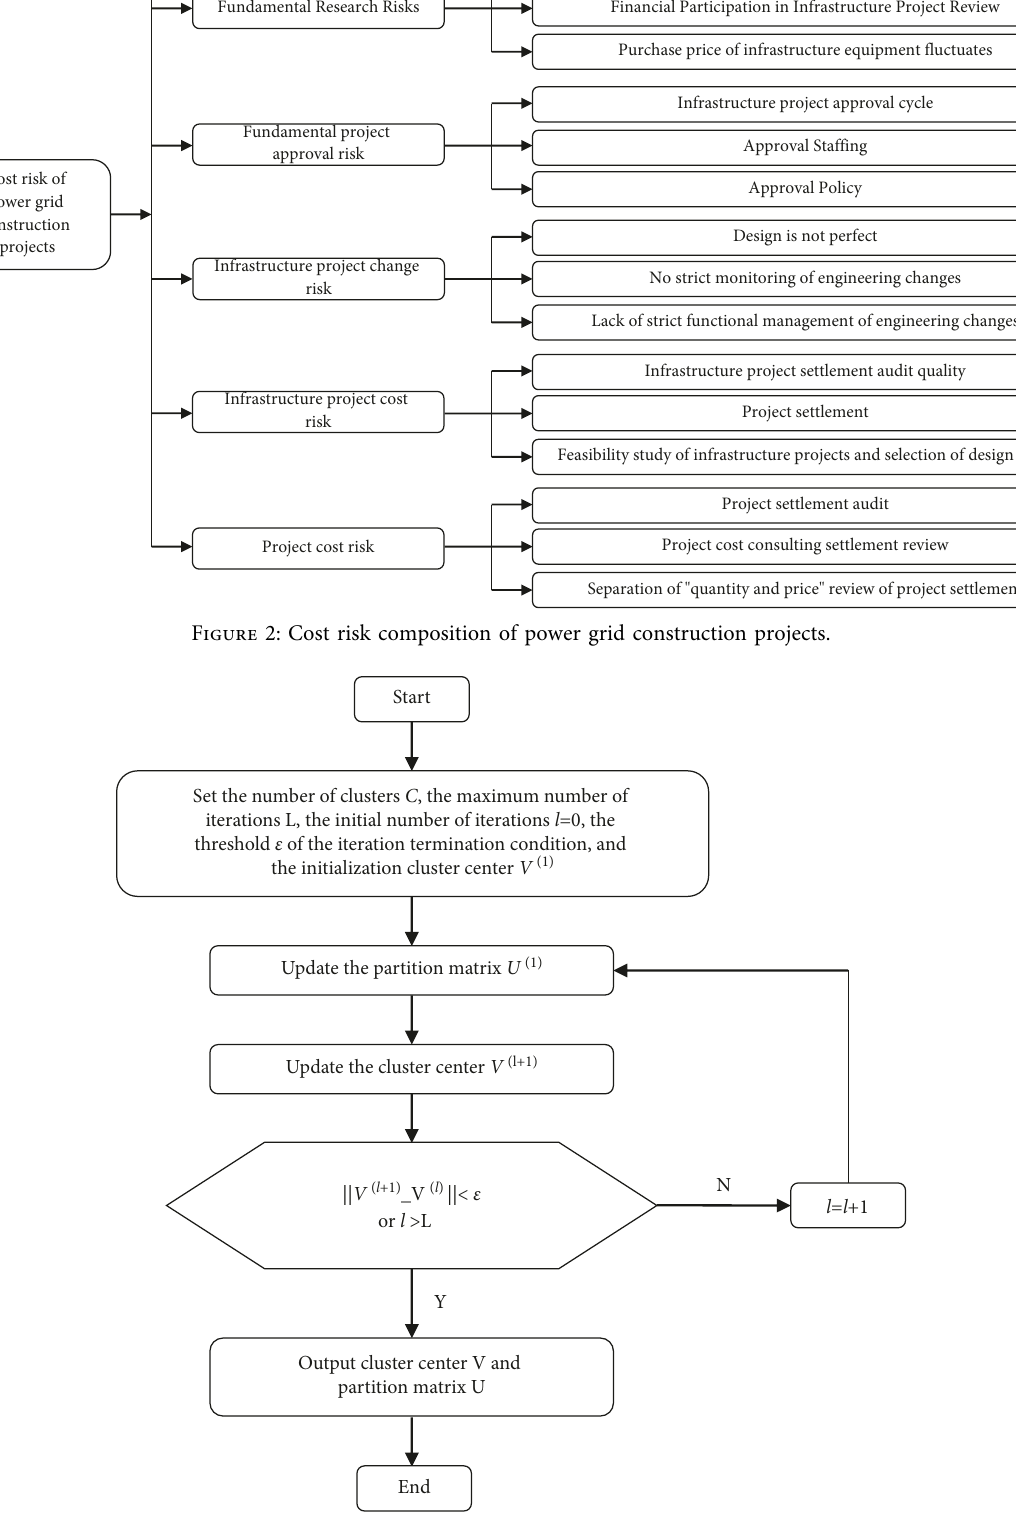
Figure 3: Flowchart of a general clustering algorithm.